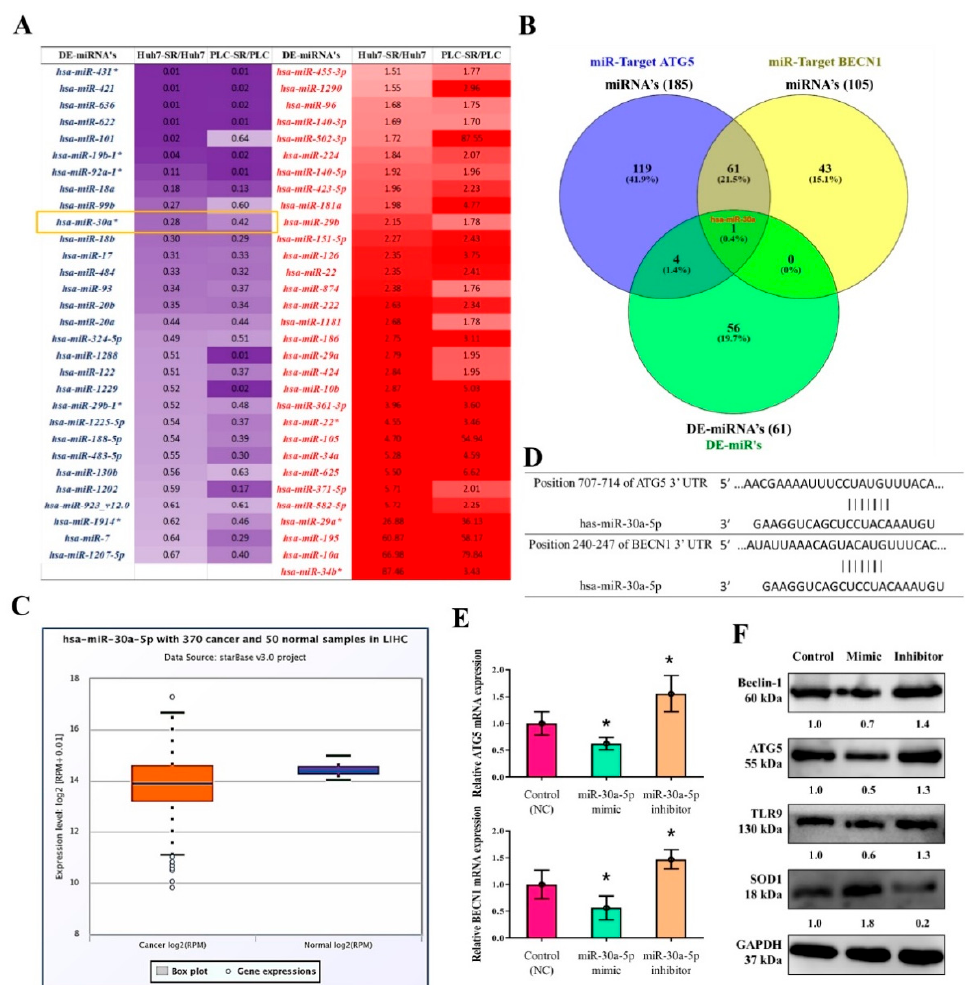
Figure 8. miR-30a-5p-regulated the expression of autophagy cell markers in sorafenib-resistant HCC cells. ( A ) Heatmap for 61 differentially expressed miRNA sorafenib-resistant cells. ( B ) miRNA target analysis of the ENCORI database revealed 185 ATG5 and 105 Beclin-1 miRNA targets. ( C ) hsa-miR-30a-5p expression in TCGA-LIHC samples analyzed using starBase v3 project tool; http://starbase.sysu.edu.cn/ (accessed on 15 June 2020). ( D ) TargetScan database indicated that hsa-miR-30a-5p predictively bound to ATG5 and Beclin-1. ( E , F ) Effect of hsa-miR-30a-5p overexpression (mimic) and in- hibition (inhibitor) on the mRNA and protein expressions of ATG5, Beclin-1, TLR9, and SOD1 in sorafenib-resistant HCC (Huh7-SR) cells. * p < 0.05.